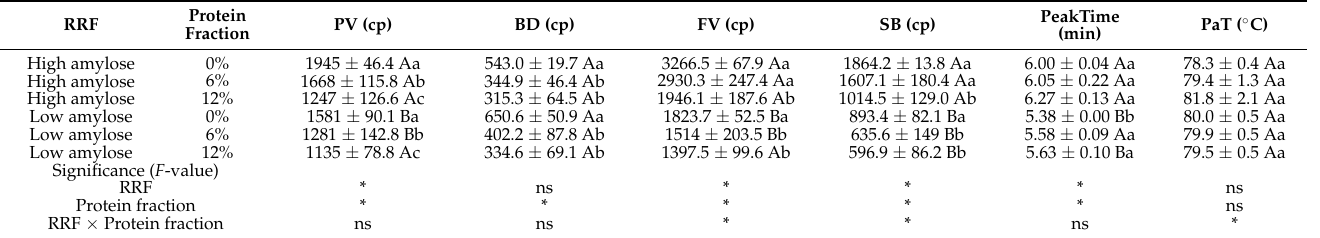
Table 1. Pasting properties of high- and low-amylose RRF composites with protein fractions